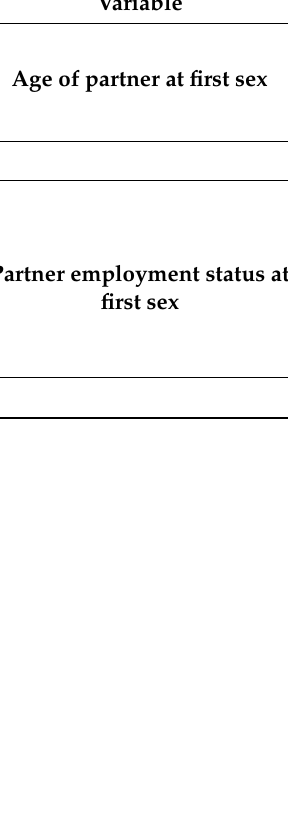
Table 3. Sexual relationship (n = 219) of